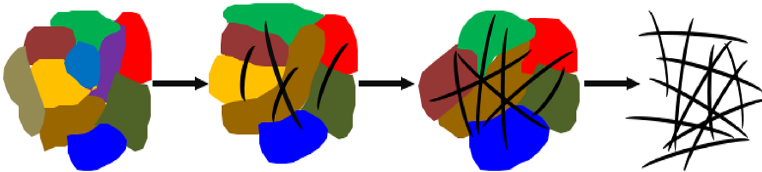
Figure 4. The growth tendency of Bi 2 O 3 crystals on the surface of Al 2 O 3 ball with calcination time increasing.